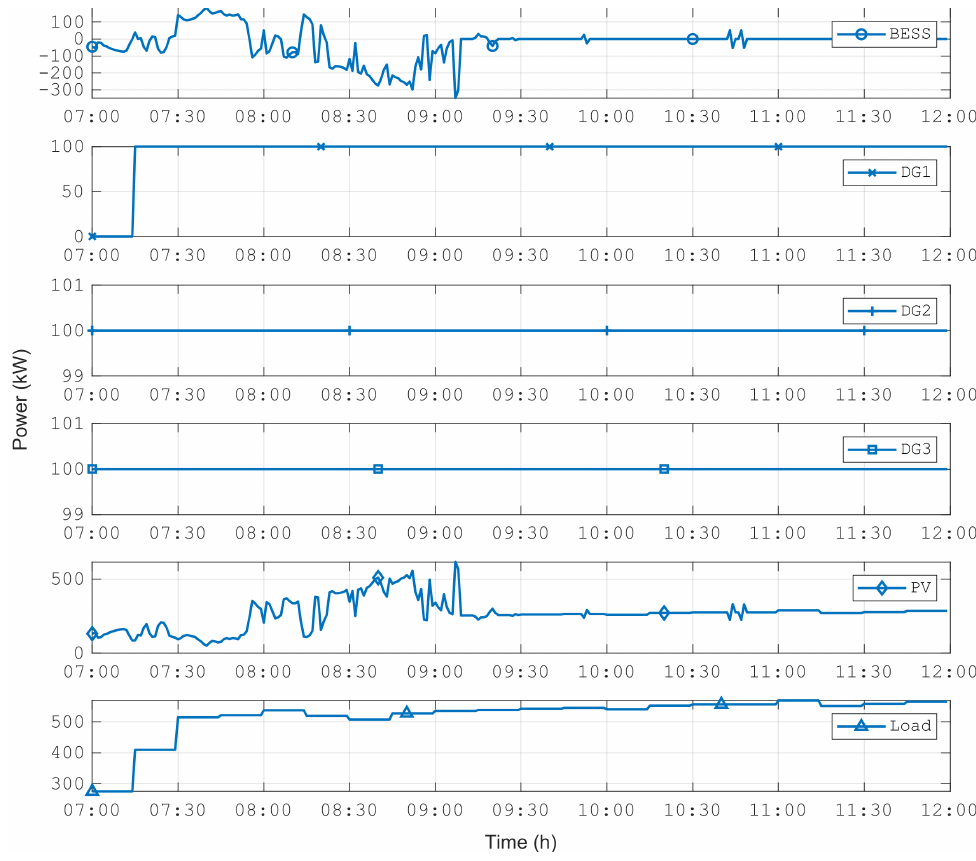
Figure 7. DERs generation and ASC load curves for off-grid operation (base